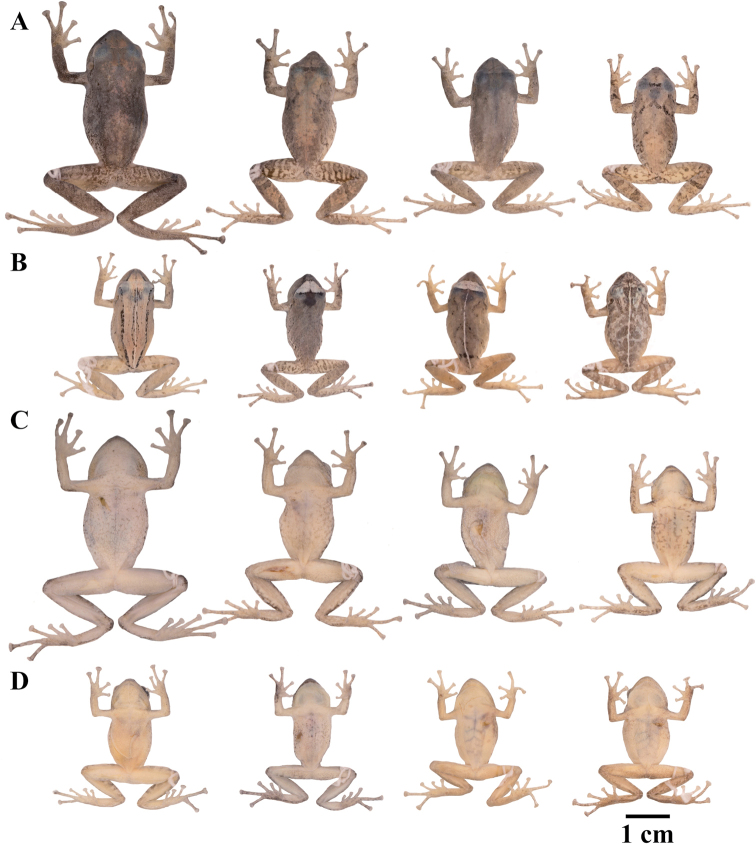
Color variation in preserved individuals of Pristimantis
torresi sp. nov. A Dorsal view of (from left to right): QCAZ 65767 (female), QCAZ 65762 (male), QCAZ 65769 (male), QCAZ 64524 (male) B Dorsal view of: QCAZ 64549 (male), QCAZ 65782 (male), QCAZ 47397 (male), QCAZ 47416 (male) C Ventral view of specimens in (A) D Ventral view of specimens in B. See Suppl. material 2 for locality data. All specimens are shown at the same scale.